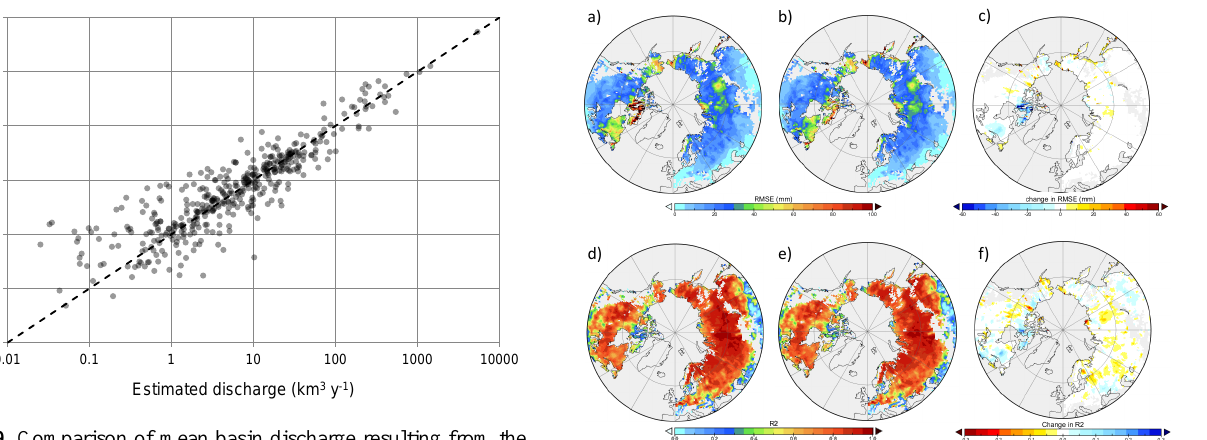
Figure 9. Comparison of mean basin discharge resulting from the analysis ( Q a ) and values based on observations (Dai et al., 2009) (darker areas indicate overlapping data points).